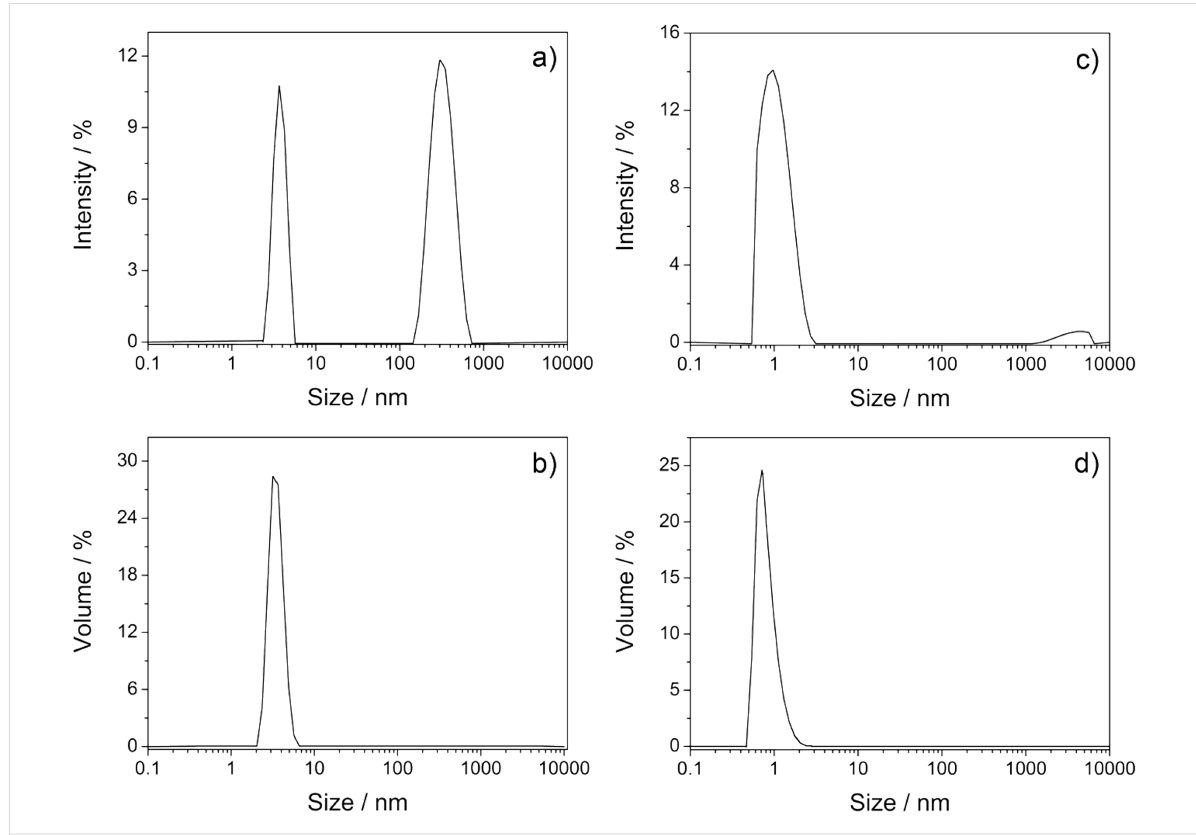
Figure 6: Size distribution of the molecular solution of C 60 with 6 mM CD 5 in water at 25.0 °C: before centrifugation (a) by intensity, and (b) by volume; and after centrifugation (c) by intensity, and (d) by volume.